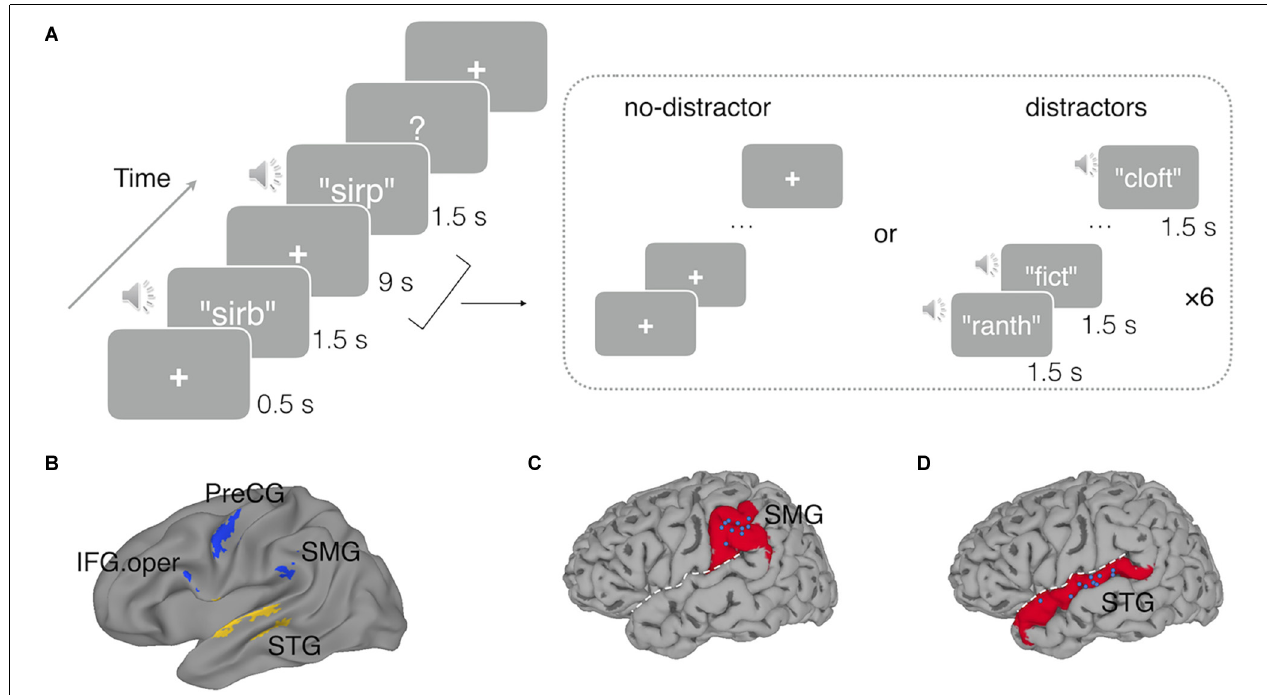
FIGURE 1 | (A) An example trial with a non-matching probe in the delayed recognition task in the fMRI experiment. In the no-distractor condition, the delay period was silent with a fixation cross; in the distractor condition, the delay period was filled with six auditory distracting nonwords, presenting at a rate of 1.5 s per each. In the TMS Experiment, a similar delayed nonword recognition task was used except that a short duration of the delay period (3 s) was used. The memory nonword was presented for 700 ms, and triple-pulse TMS stimulation was triggered at either 700 ms (early) or 1,300 ms (late) after the onset of the memory nonword. (B) Functional regions of interest used in Experiment 1 derived from a prior study (Yue et al., 2019): the left superior temporal gyrus (STG), the left supramarginal gyrus (SMG), the opercular part of the left inferior frontal gyrus (IFG.oper), and the left precentral gyrus (PreCG). (C) The blue dots indicate the target sites stimulated by TMS in the left SMG and in (D) the left STG, with each dot representing a subject. White dashed line represents the Sylvain fissure. The underlying red regions mark the anatomical parcellations of the left SMG and left STG for